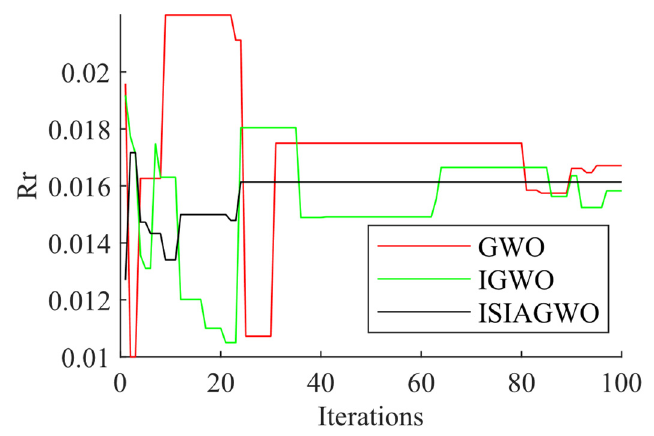
Figure 14. The rotor resistance of DFIG identification convergence curve. The stator inductance of DFIG identification convergence curve, shown in Figure 15.